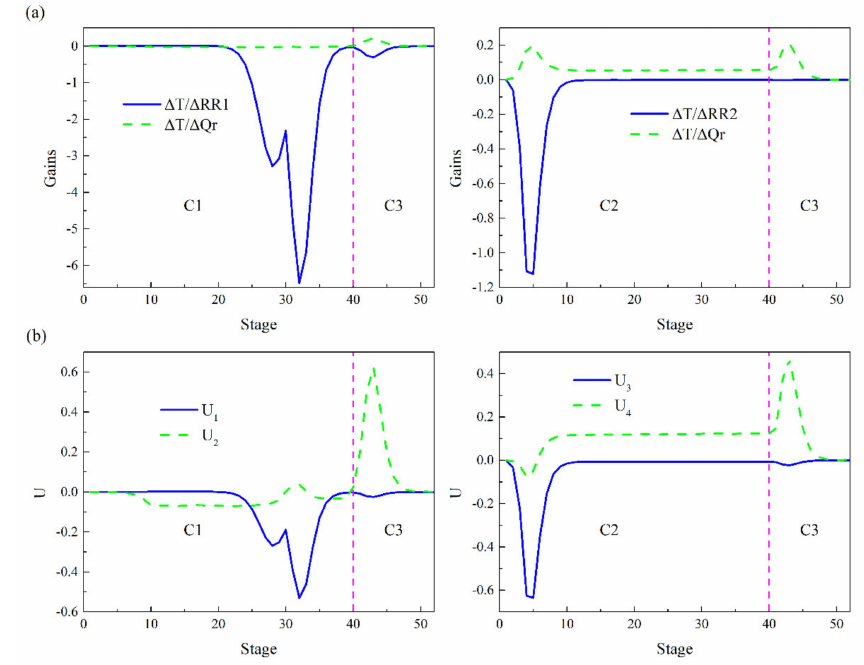
Figure 9. ( a ) Steady-state gains ( b ) SVD analysis for